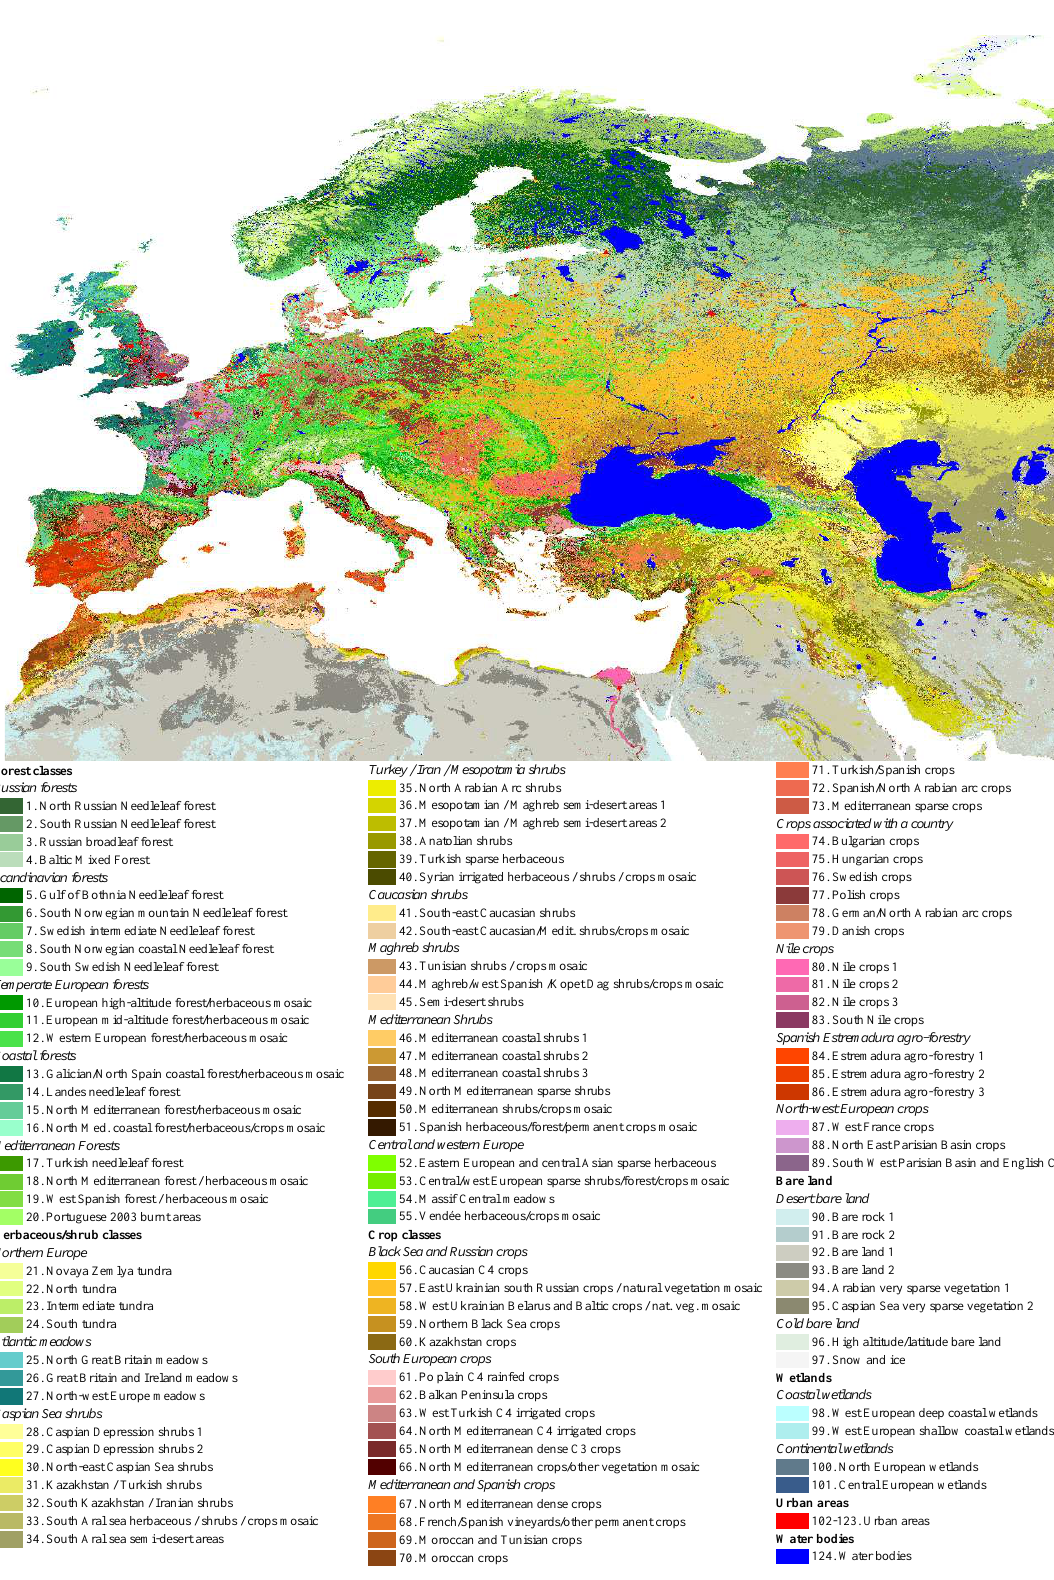
Figure 7. Simplified map ECOCLIMAP-II/Europe with 103 classes enhancing the dominant patterns.